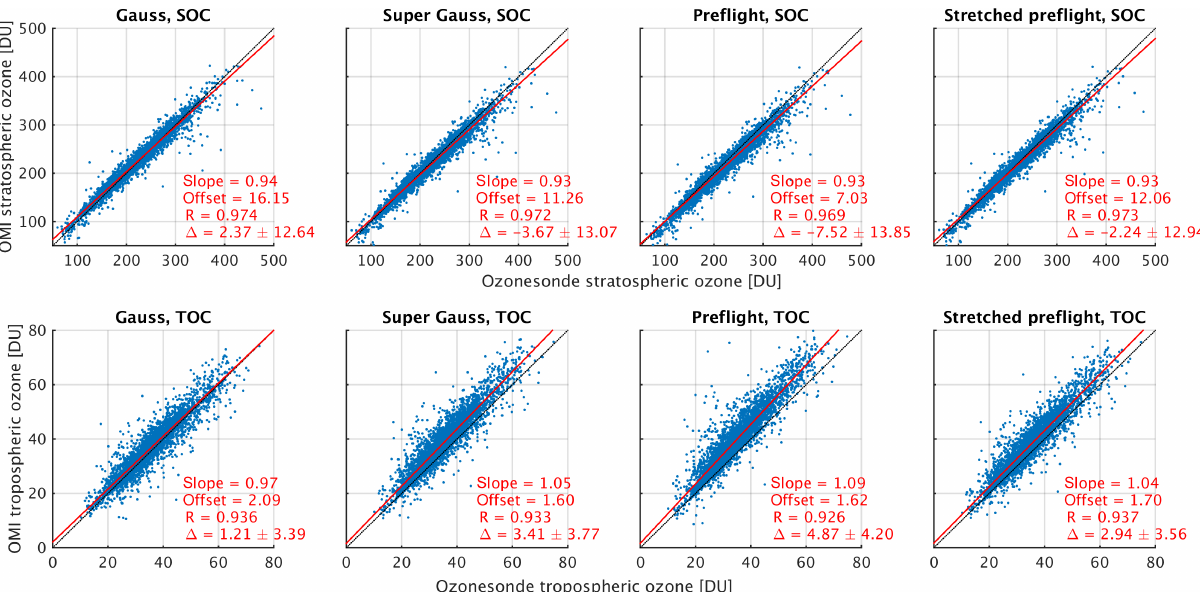
Figure 12. Similar to Fig. 9 but for the UV2-only case. Only SOC and TOC are shown. The number of successful validations is 4461 (same as for all slit functions, see Fig.